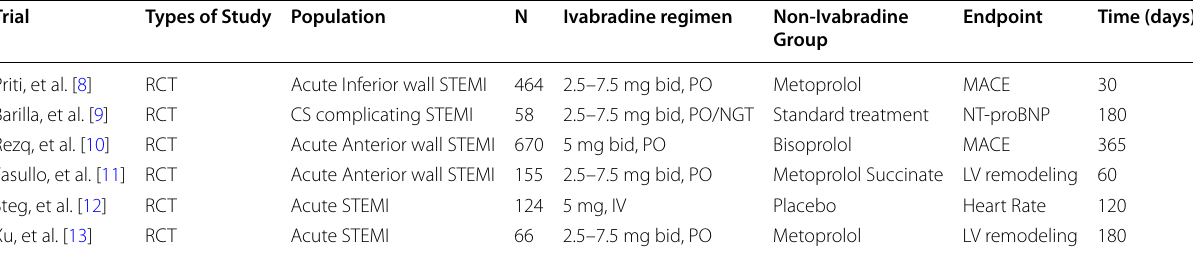
Table 1 Characteristics of included studies